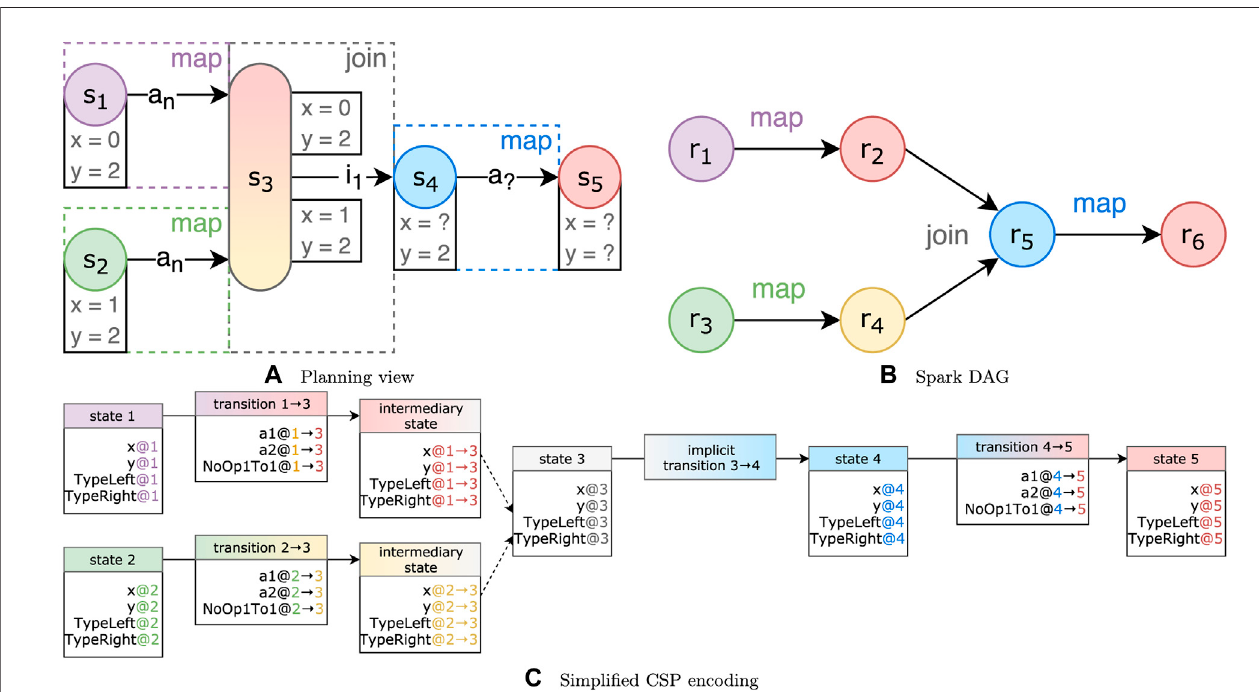
FIGURE 4 | Three views of an example transition system with a join state and con fl icting state variables. Variable x in s 4 could have multiple values.